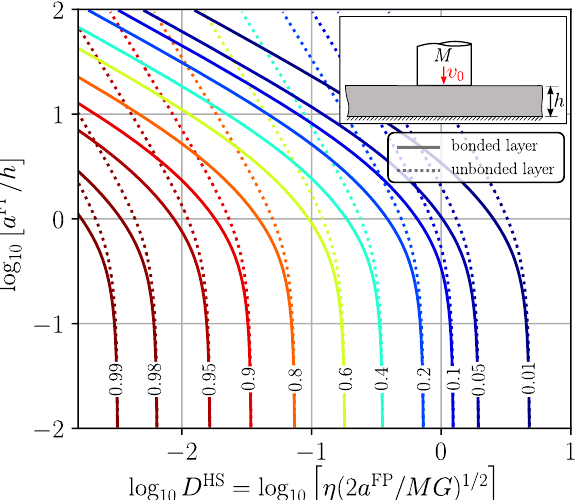
Figure 11. Coefficient of restitution for the quasi-static impact of flat punch with a viscoelastic layer modeled using the Kelvin–Voigt